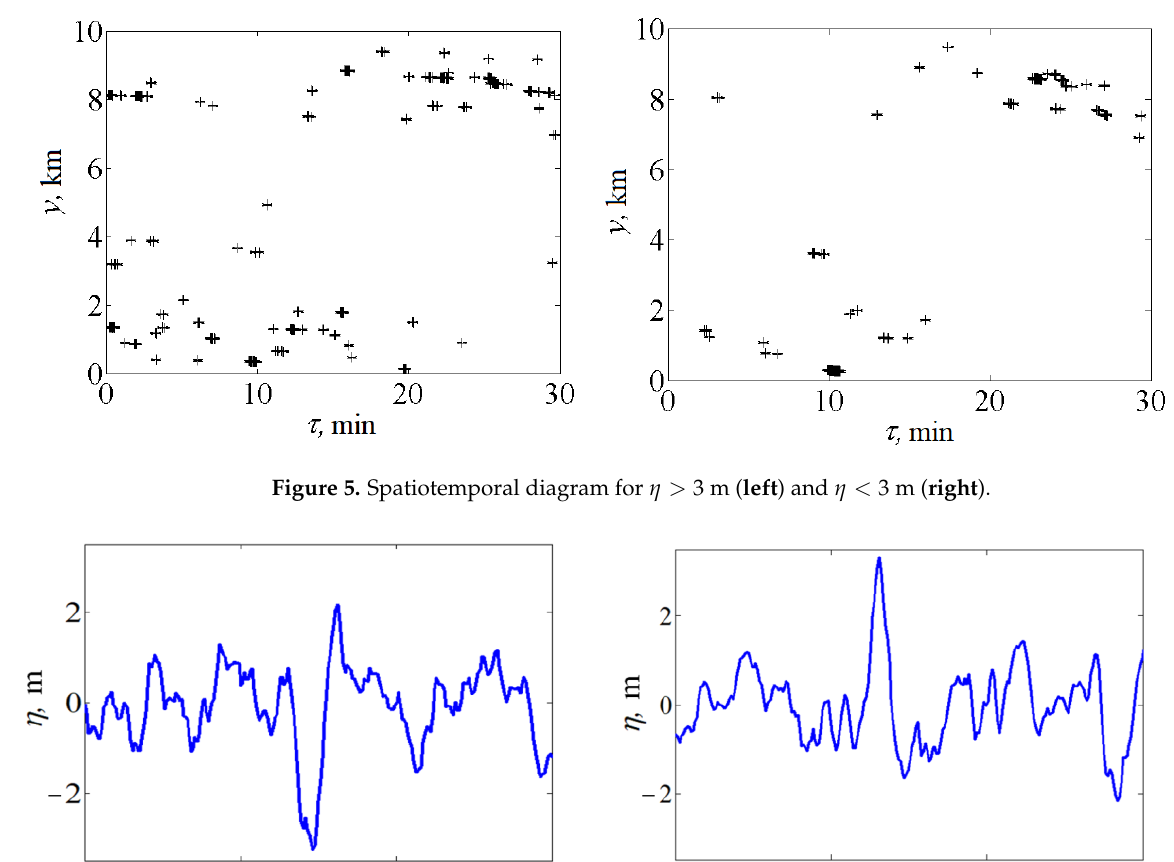
Figure 6. Profiles of freak waves occurred in random wind wave field.